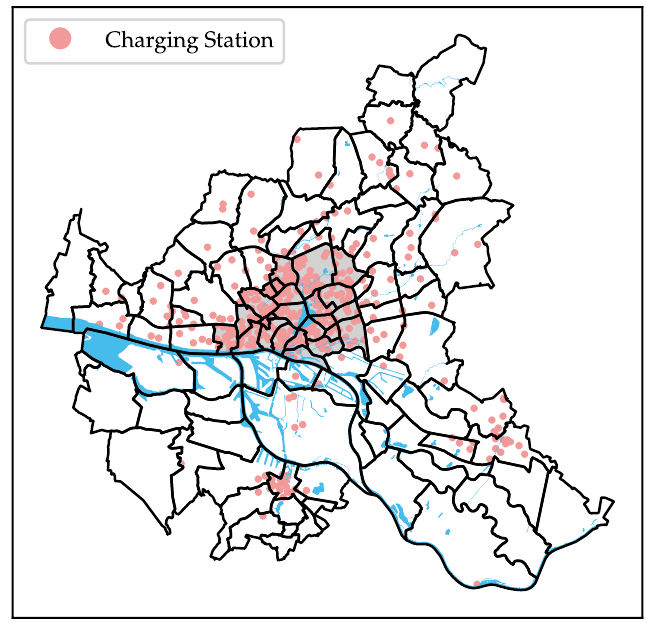
Figure 6. Hamburg charging